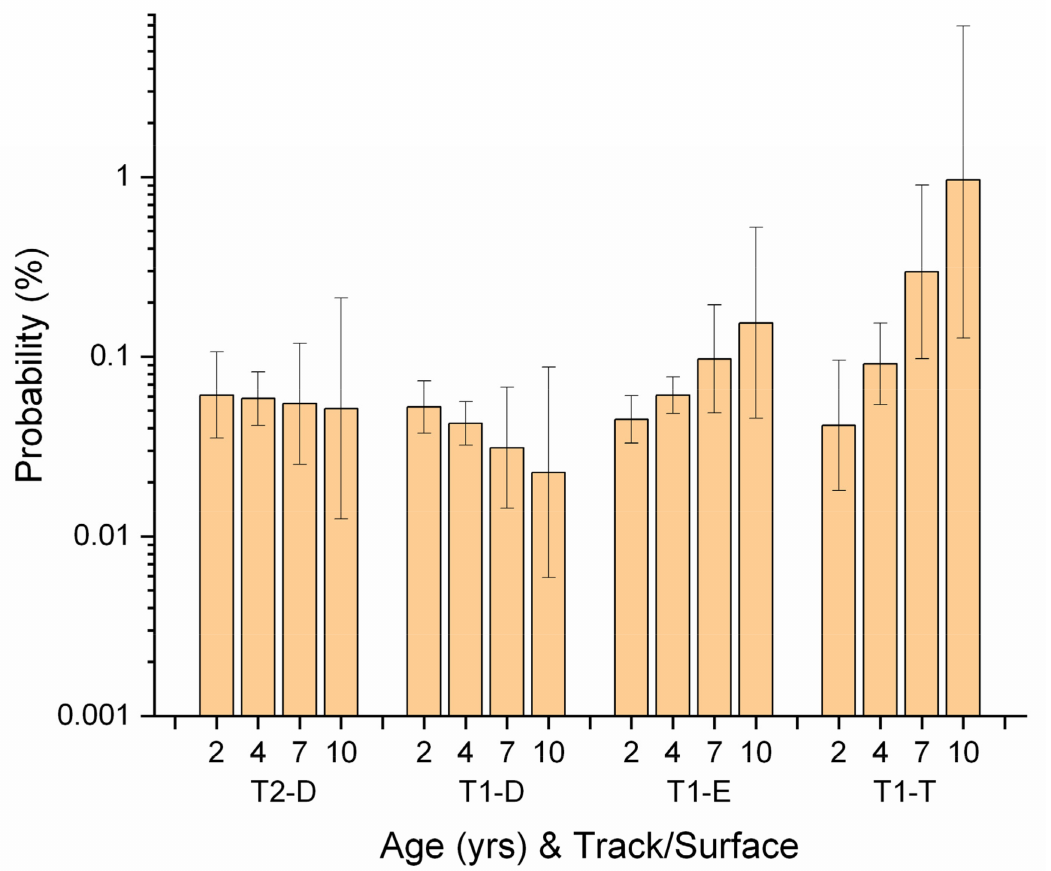
Figure 6. Probability (%) of fatality for workout work-events for Ontario Thoroughbred racehorses for the period 2003–2015, unit of interest—workout work-event, and describing an interaction between horse age (AGE) and track/surface combination (TS, AGE*TS) identified during multivariable logistic regression modelling. Track/surface combinations were used because not all surfaces were available at both tracks. On dirt surfaces at both tracks there was a non-significant trend to decreasing probability as AGE increased, but for Track 1 synthetic and turf surfaces, probability of fatality increased with AGE. (Note log scale on y -axis.) T2-D—Track 2 dirt; T1-D—Track 1 dirt; T1-E—Track 1 synthetic; T1-T—Track 1